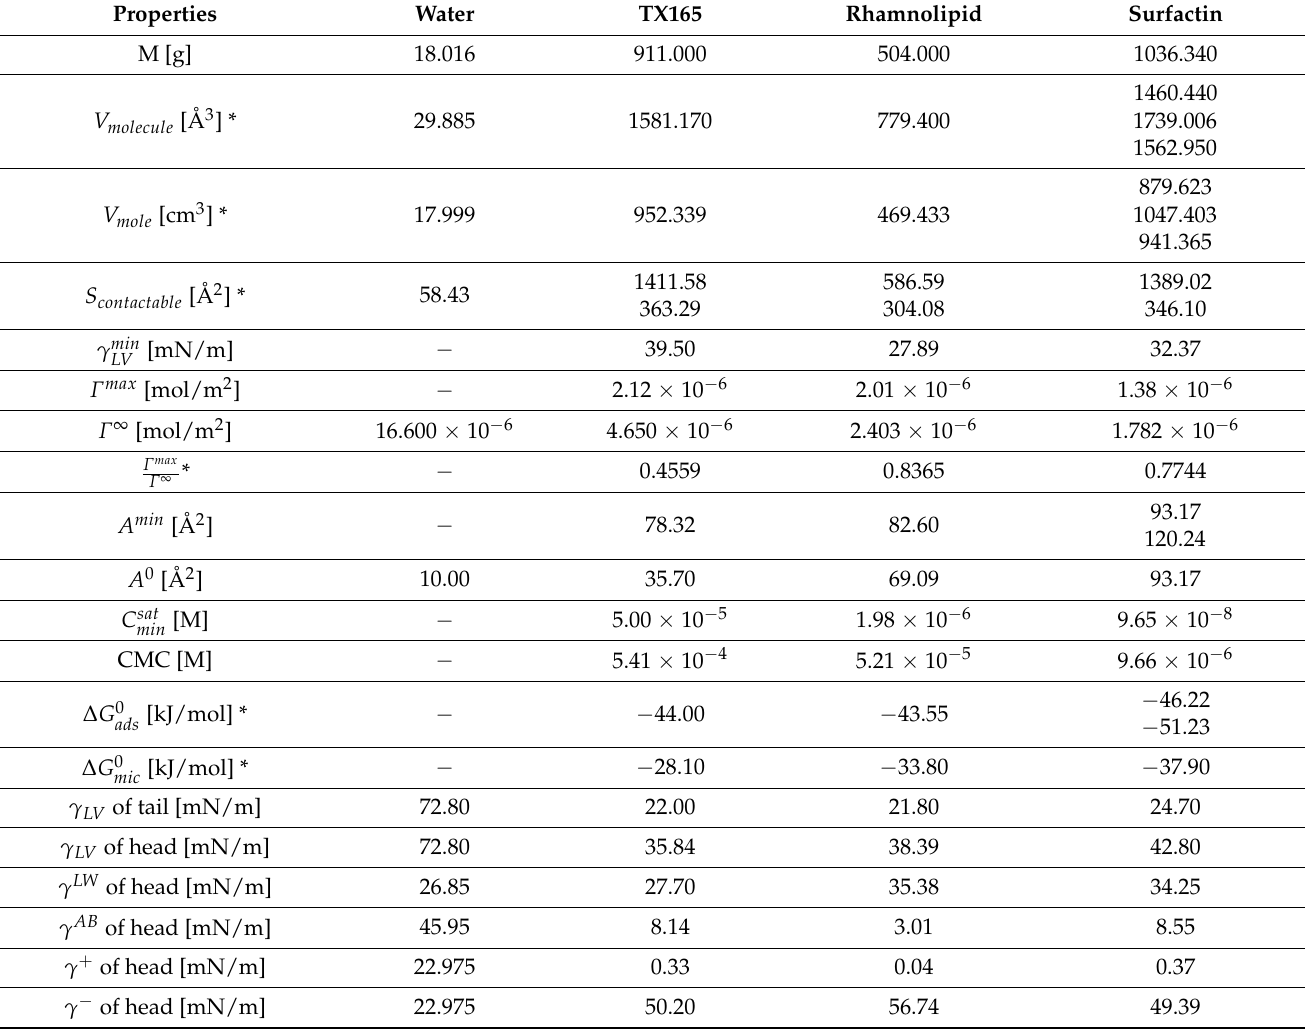
Table 1. The different physicochemical properties of water, RL, SF, and